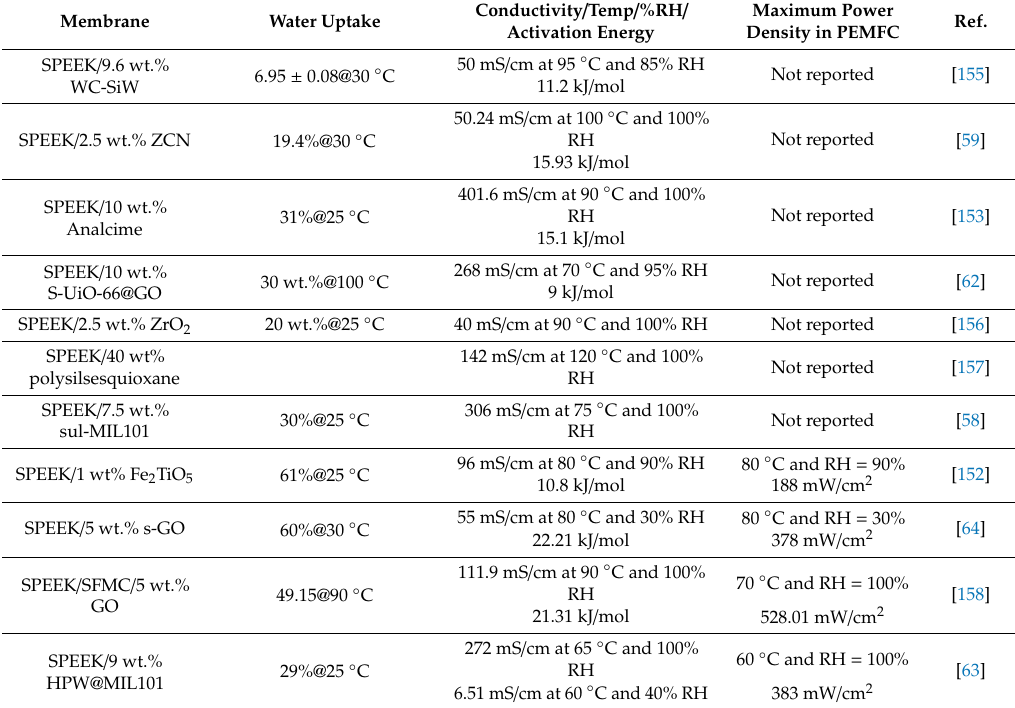
Table 4. Comparison of proton conductivities of sulfonated PEEK-based composite membranes and their PEMFC